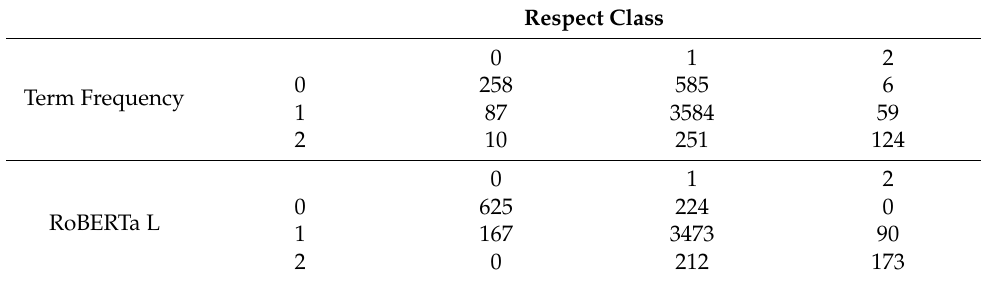
Table 4. Confusion matrix for the worst- and best-performing classification models based on features from the term frequency and Roberta large fine-tuned (RoBERTa) feature extraction methods. Num- bers corresponding to class labels are: 0, disrespectful; 1, respectful; and 2, very respectful. In the best-performing model; no data instances were misclassified between the “disrespectful” and “very respectful”